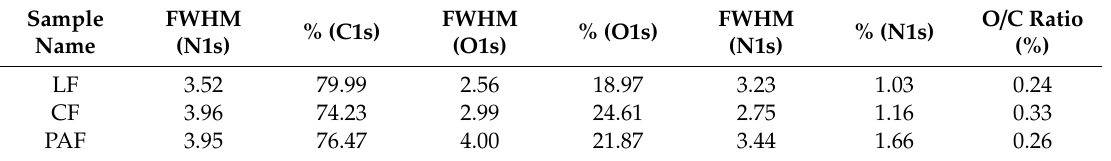
Table 2. Elemental content (wt.%) of Linen Fiber and its modified forms.